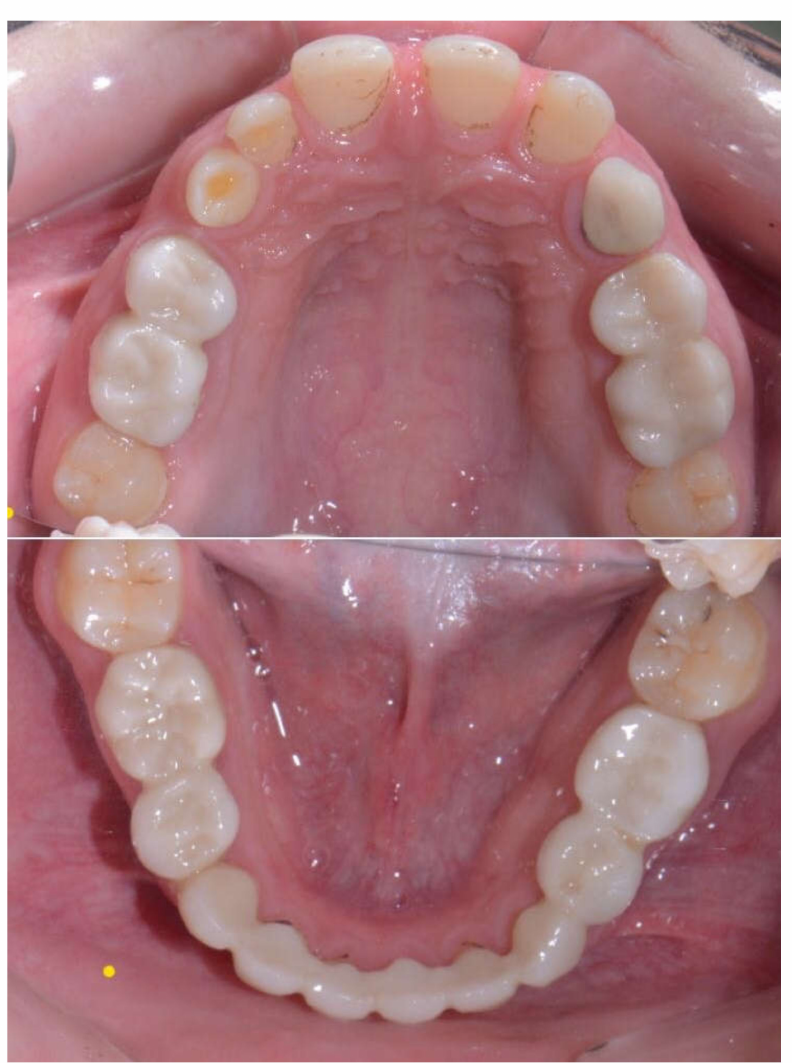
Figure 8. Porcelain teeth restoration